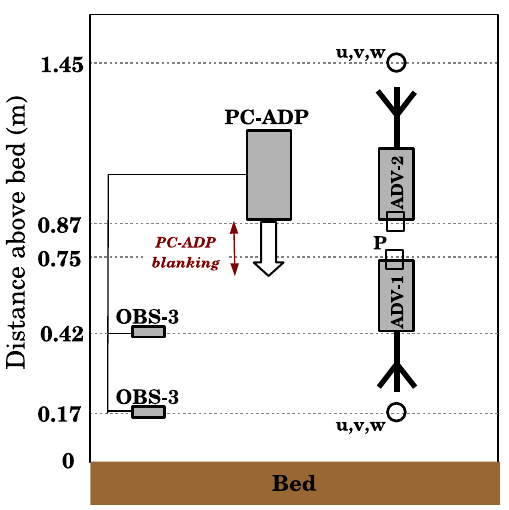
Figure 2. Setup of the oceanographic instrumentation. The big white arrow indicates the direction of signal transmission of the Pulse Coherent Acoustic Doppler Profiler (PC-ADP); the thin two-headed arrow indicates the blanking distance between the signal transmissing head and the first measurement bin. The circles denote the sampling volumes of the Acoustic Doppler Velocimeters (ADVs) for velocity measurements; the squares denote the sampling volumes of the ADVs for pressure